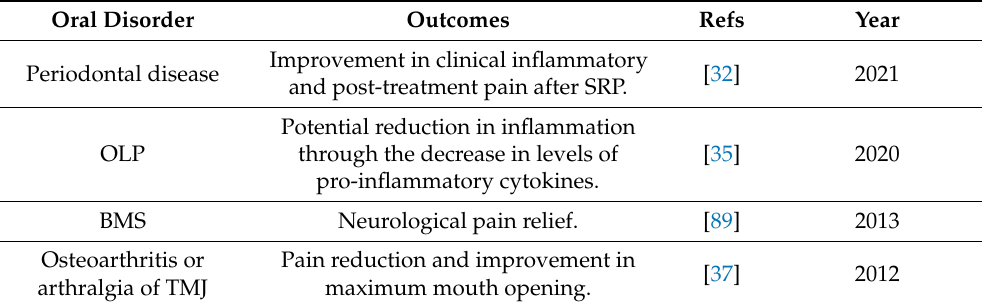
Table 2. Summary of PEA’s effects in the management of diseases of dental